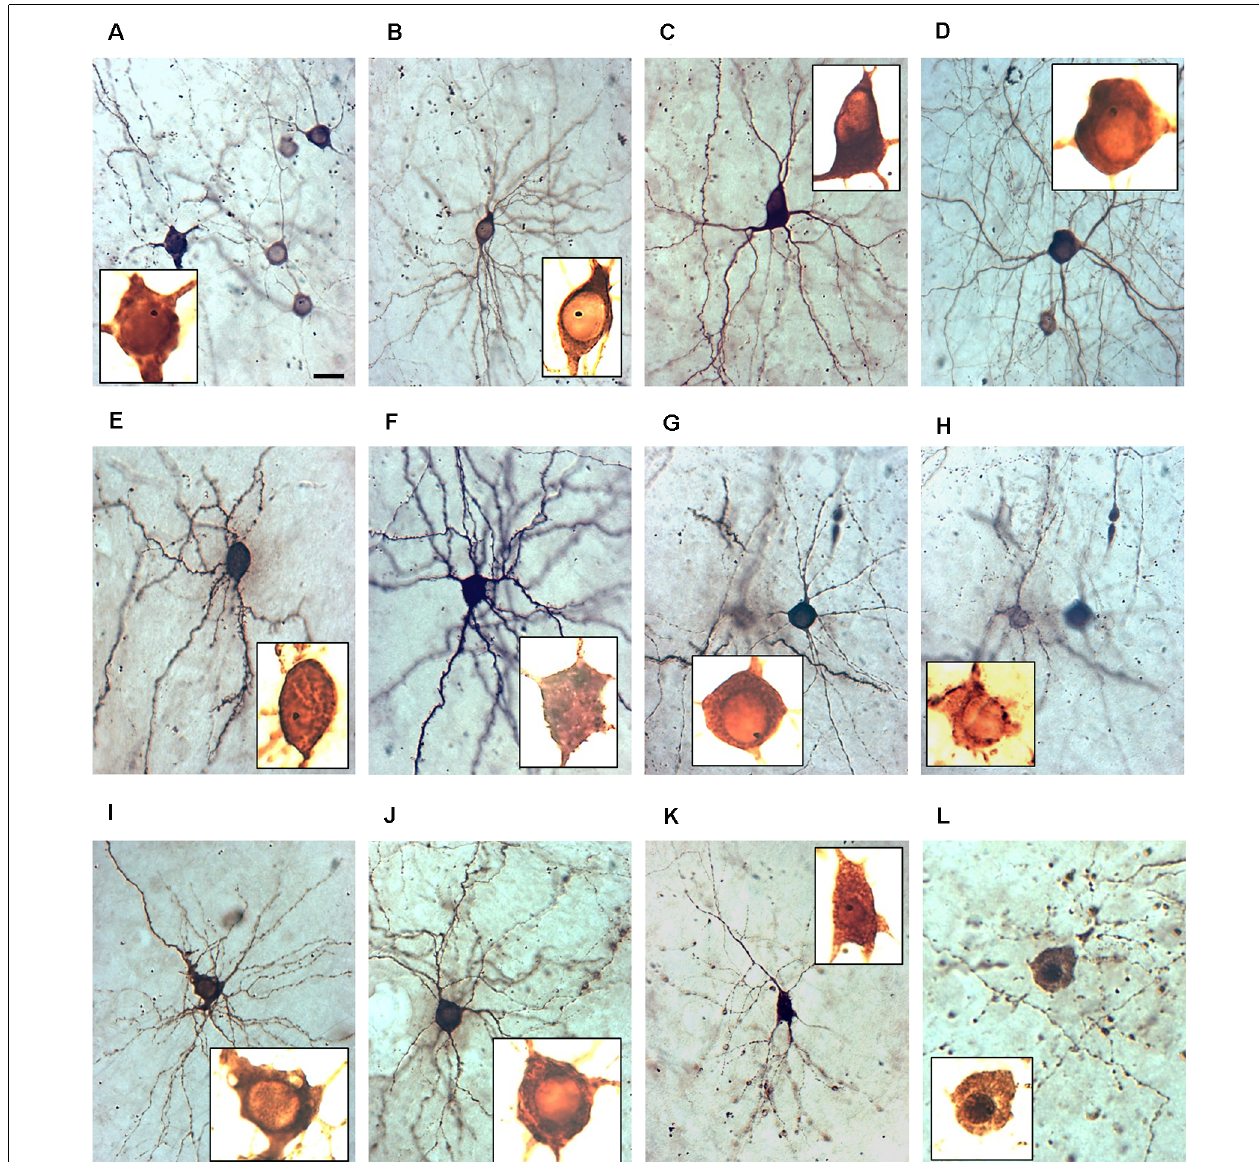
FIGURE 3 | The nuclear phenotype of GECI transfectants. All micrographs have been taken at 400 × magnification at DIV 22–25. The insets show the somata photographed at 1,000 × magnification with extreme overexposure to visualize the inner structure and nuclei, all scaled identically. Note that nuclei often harbored a single gold particle. The dark staining of the nucleus is an indicator of the filling with calcium indicator protein. (A) Group of five GCaMP6m expressing neurons, one with an occluded nucleus stained as dark as the cytosol. (B) GCaMP5G expressing healthy pyramidal neurons with the translucent nucleus. (C) GCaMP3 expressing healthy interneuron with the translucent nucleus. (D) GCaMP5G expressing healthy interneuron with the translucent nucleus. (E) TN-XXL expressing healthy pyramidal neurons with the occluded nucleus. (F) GCaMP3 expressing healthy pyramidal neurons with the occluded nucleus. (G) TN-XXL expressing healthy interneuron with the translucent nucleus. (H) TN-XXL expressing pyramidal cells with a leaky soma and a translucent nucleus surrounded by immunoreactive aggregates. (I) GCaMP6m-X C expressing pyramidal cell with vacuolar inclusions and translucent nucleus. (J) TN-XXL expressing degenerating pyramidal cells with swellings along a dendrite and translucent nucleus. (K) TN-XXL expressing degenerating pyramidal cell with swellings along all dendrites and occluded nucleus. (L) TN-XXL expressing dead neurons with a dark nucleus surrounded by a cloud of former dendritic swellings and a dark nucleus. Pial surface to the top. Scale bar in (A) : 20 µ m for all 400 × micrographs. The 1,000 × micrographs are all cropped to show the soma and all are scaled identically to allow comparison of nuclear size.